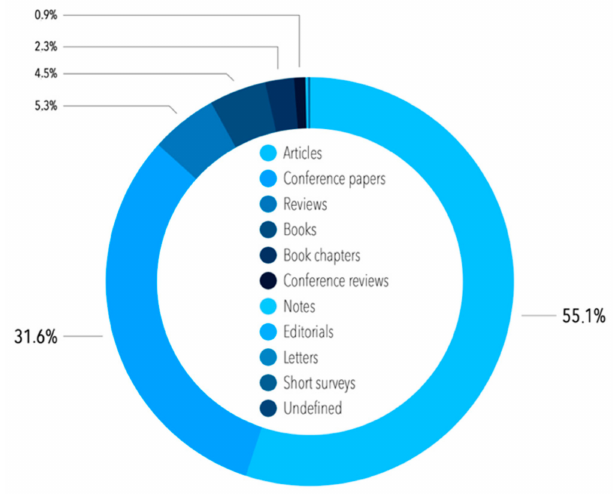
Figure 3. Percentage of publications per document type.